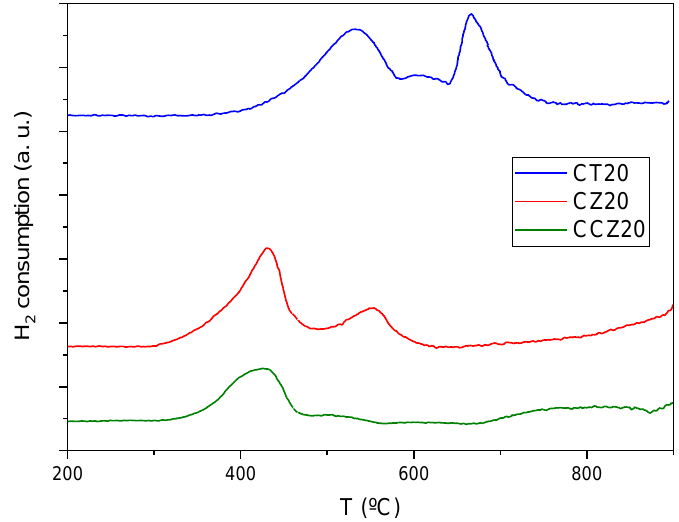
Figure 7. H 2 -TPR comparison of CCZ20, CCZ20 and CT20 .